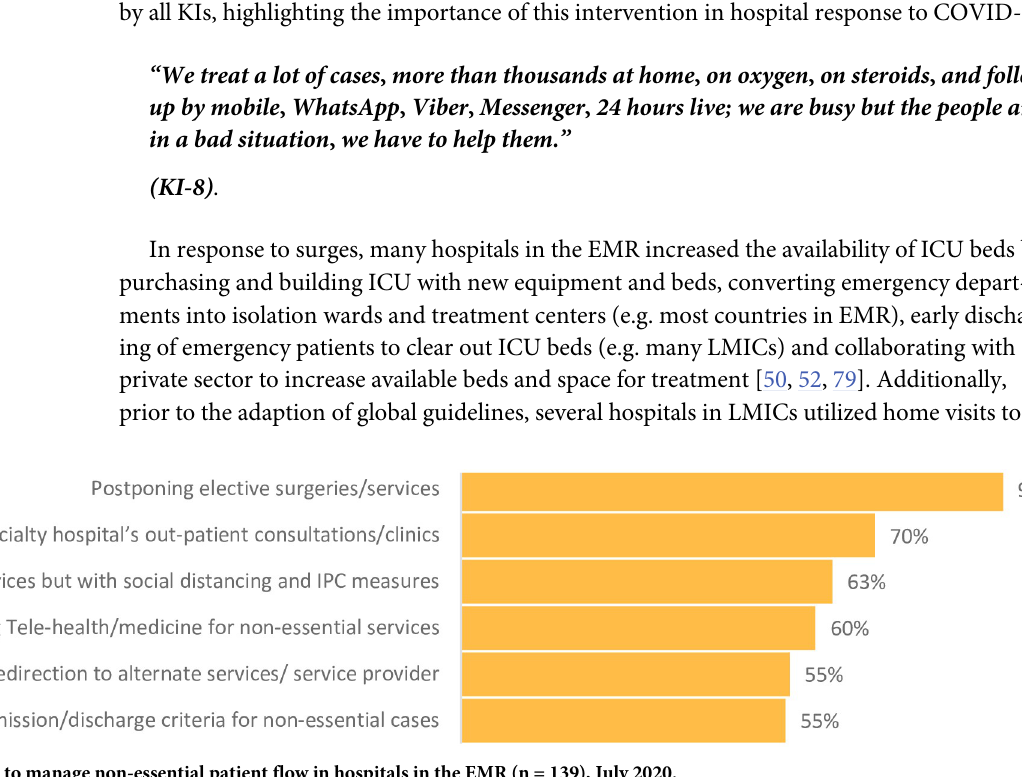
Fig 5. Strategies to manage non-essential patient flow in hospitals in the EMR (n = 139), July 2020.